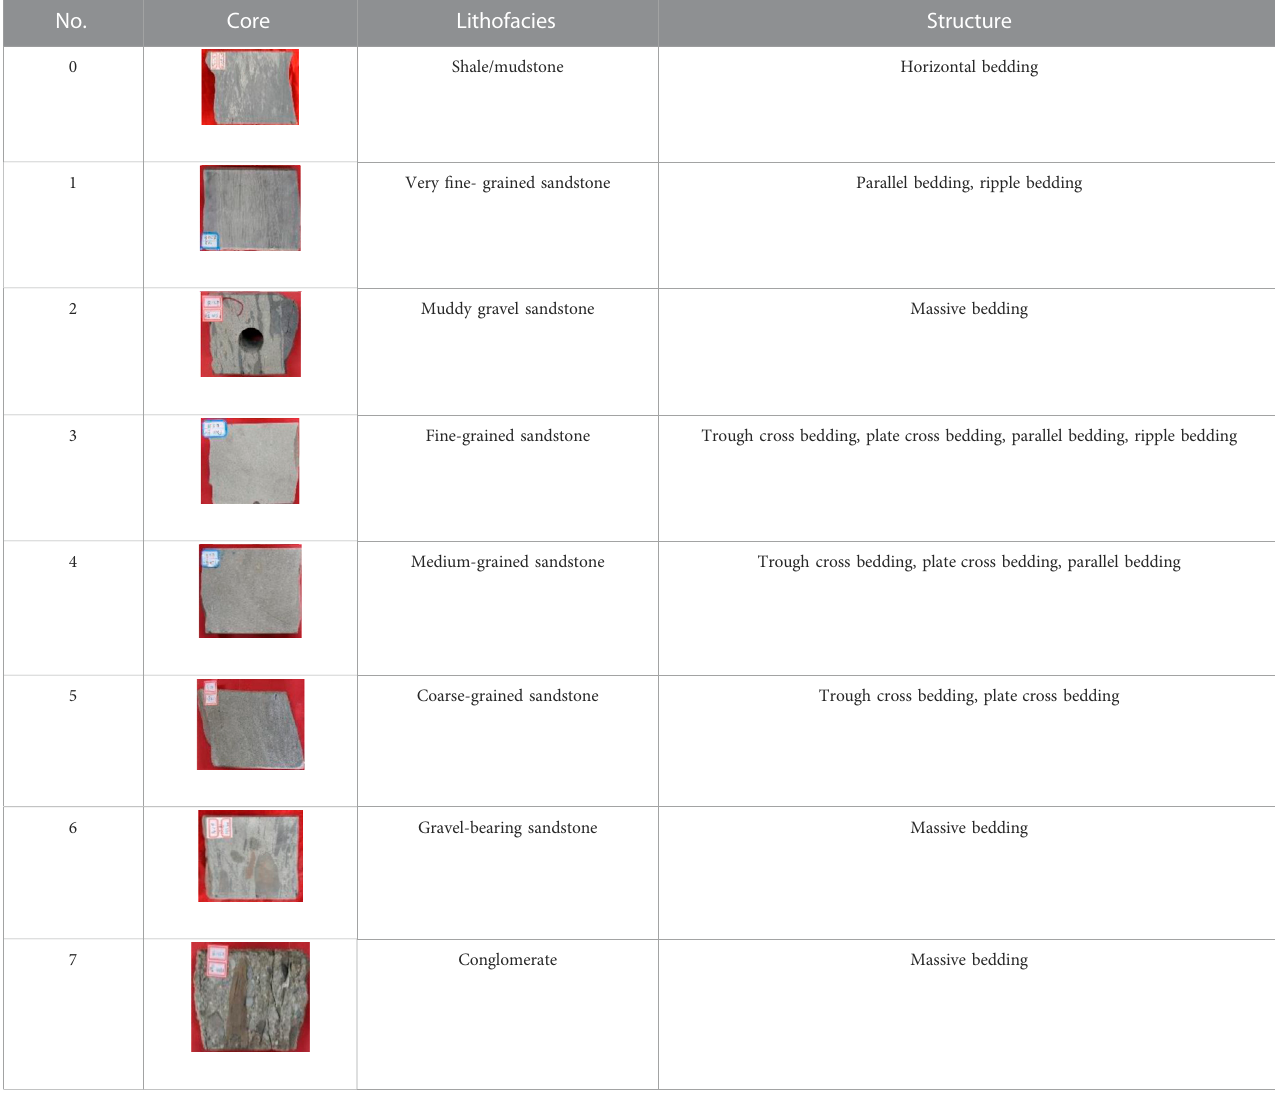
TABLE 1 Lithofacies classi fi cation comparison table for the Sangonghe Formation in the Moxizhuang area.